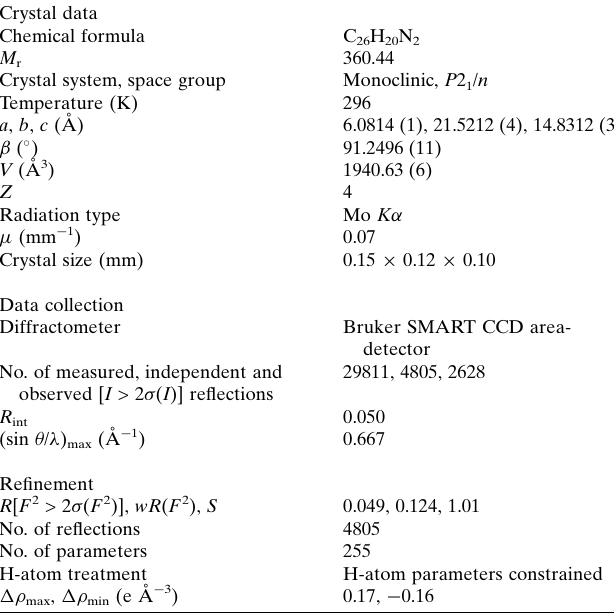
Table 2 Experimental details. Crystal data Chemical